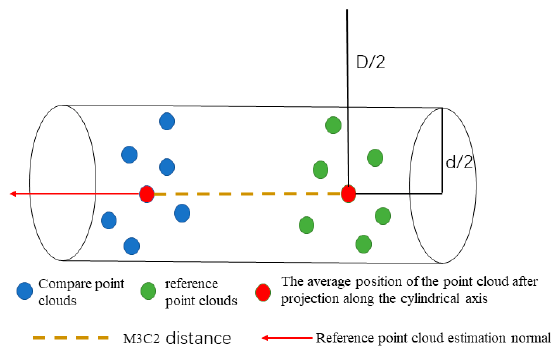
Figure 1. Schematic diagram of M3C2 distance algorithm.